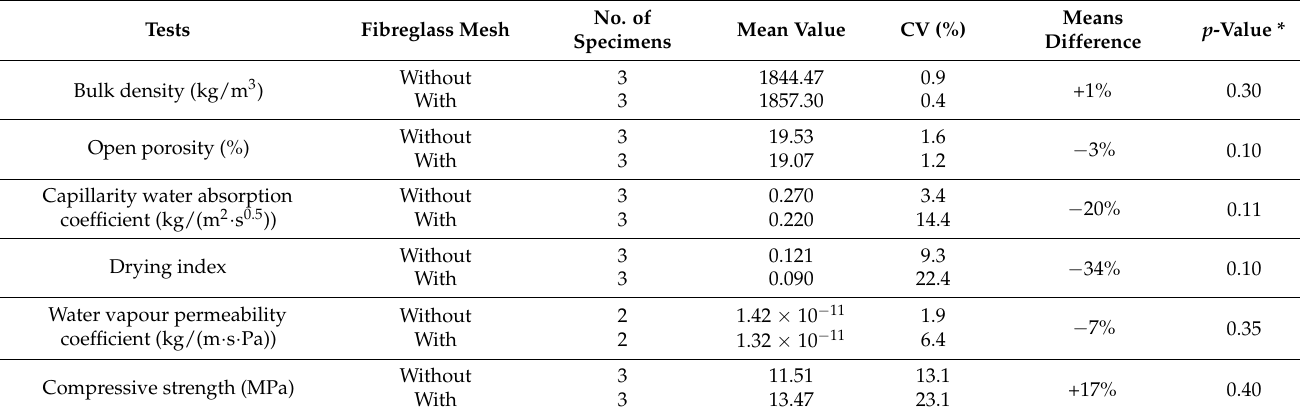
Table 3. Cement mortar applied to the concrete slab substrate.